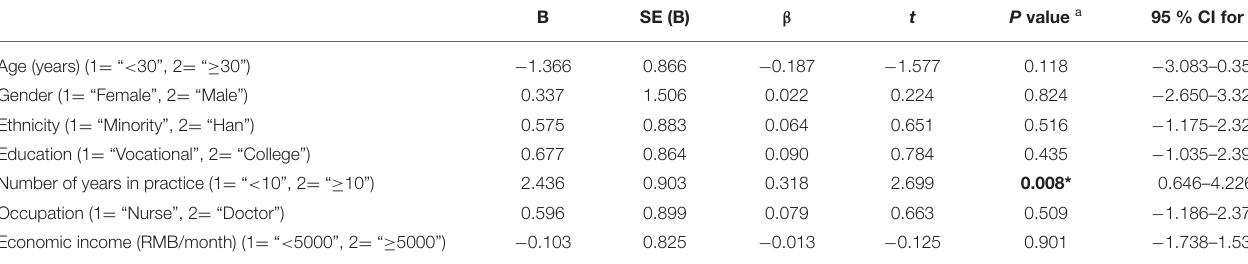
TABLE 8 | Multiple linear regression analysis for factors influencing total